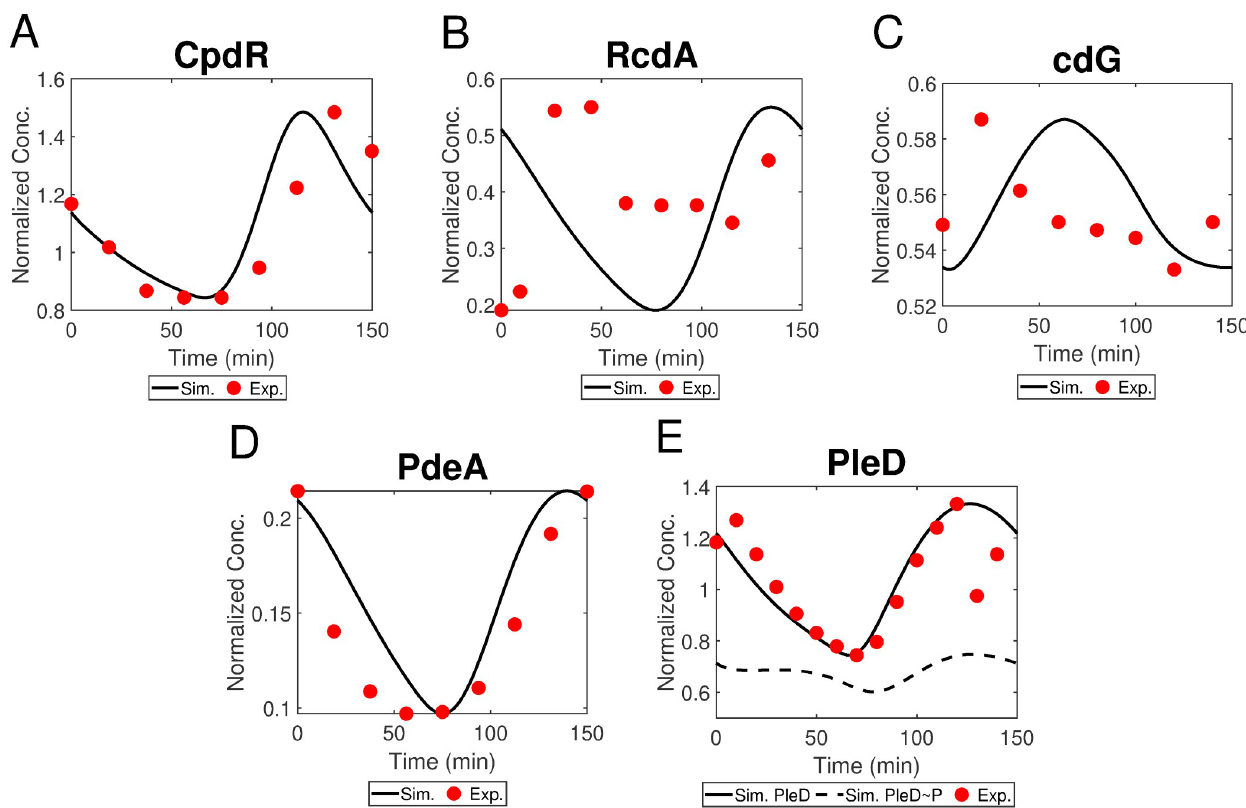
Fig 9. (A-E) The dynamics of total CpdR, RcdA, cdG, PdeA, total PleD, and PleD * P in simulation with the corresponding experimental data. Experimental data of CpdR is from Iniesta et al. [25], RcdA is from McGrath et al. [44], cdG is from Abel et al. [31], and PdeA as well as total PleD are from Abel et al. [45].